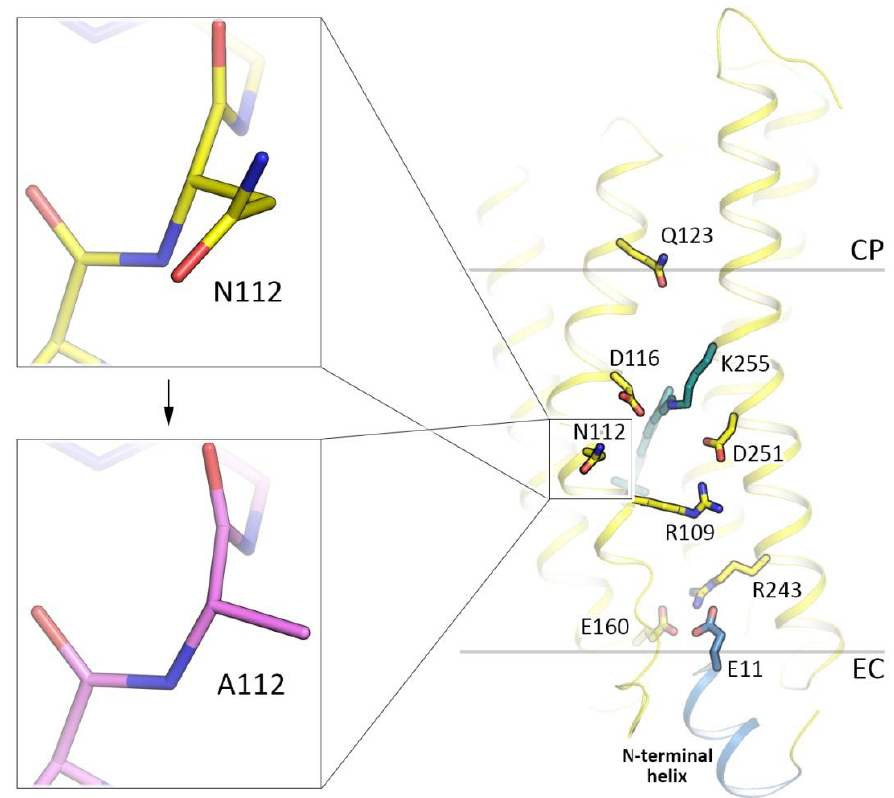
Figure 4. Location of the N112A substitution site (yellow, the WT of KR2, PDB ID: 6YC3 [41]; magenta, the N112A variant of KR2, present work, PDB ID: 6YT4). Hydrophobic / hydrophilic membrane core boundaries were calculated with PPM server [59] and are shown with gray lines. Cytoplasmic (CP) and extracellular (EC) sides of the membrane are marked. N-terminal α -helix of KR2 is colored blue. Helices A, B, and BC loop are hidden for clarity.